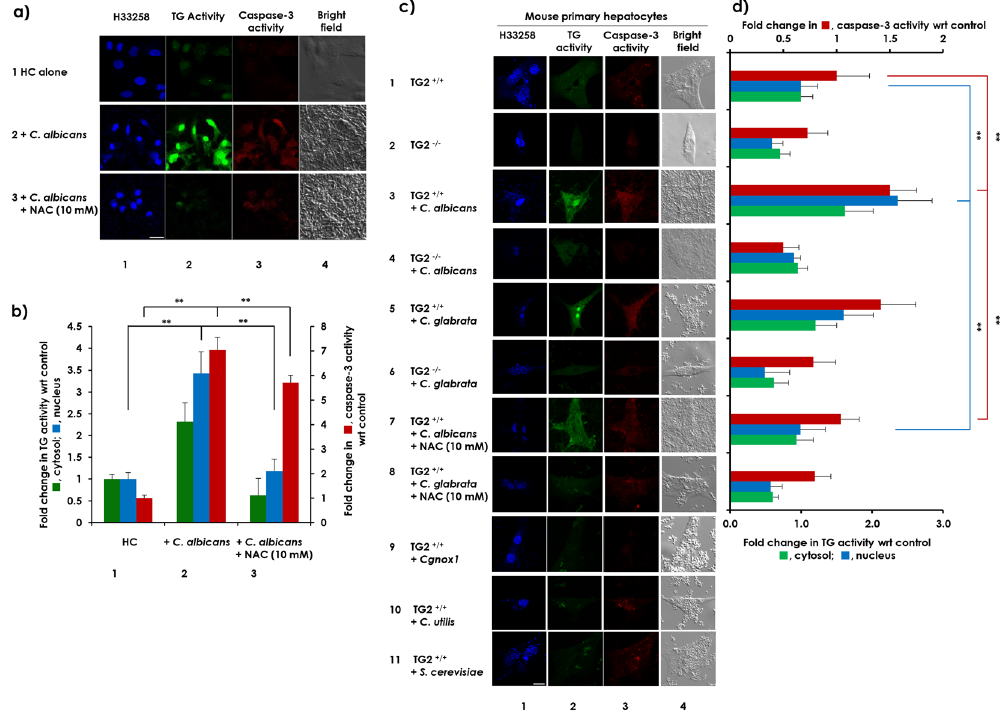
Figure 5. ROS derived from C. albicans and C. glabrata induced cell death in HC cells and mouse primary hepatocytes. ( a ) HC cells were seeded at 2 × 10 5 cells per well in a 6-well plate and were incubated overnight and then treated with 5-BAPA and were incubated alone (row 1) or were co-incubated with 5 × 10 6 C. albicans cells (row 2) in the presence of 10 mM NAC (row 3). ( c ) Primary hepatocytes isolated from livers of TG − / − mice and their TG + / + littermates were seeded at 5 × 10 5 cells per well in a 6-well plate and incubated overnight. The next day, the cells were treated with 5-BAPA and incubated alone (rows 1 and 2) or were co-incubated with 5 × 10 6 C. albicans cells (rows 3 and 4) in the presence of 10 mM NAC (row 7) or with the same number of C. glabrata cells (rows 5 and 6) in the presence of 10 mM NAC (row 8), Cgnox1 (row 9), C. utilis (row 10), and S. cerevisiae (row 11). The blue fluorescence from H33258 dye (column 1) was observed along with the green fluorescence signals from TRITC staining 5-BAPA representing TG activity (column 2) and red fluorescence from Alexa 488 representing caspase-3 activity (column 3) using a confocal microscope. An image taken under bright field (column 4) is also shown. Scale bar = 20 µ m. Representative images from at least 3 fields from a single experiment are shown. ( b and d ). Fluorescence intensities from TRITC in both the cytoplasm and nucleus along with fluorescence intensities from Alexa 488 were quantitated using ZEN 2011 software, and after subtraction of background intensities, the relative TG and caspase-3 activity levels are represented in bar graphs, with the levels from HC cells or TG2 + / + primary hepatocytes incubated alone as the control (mean ± SD, n =